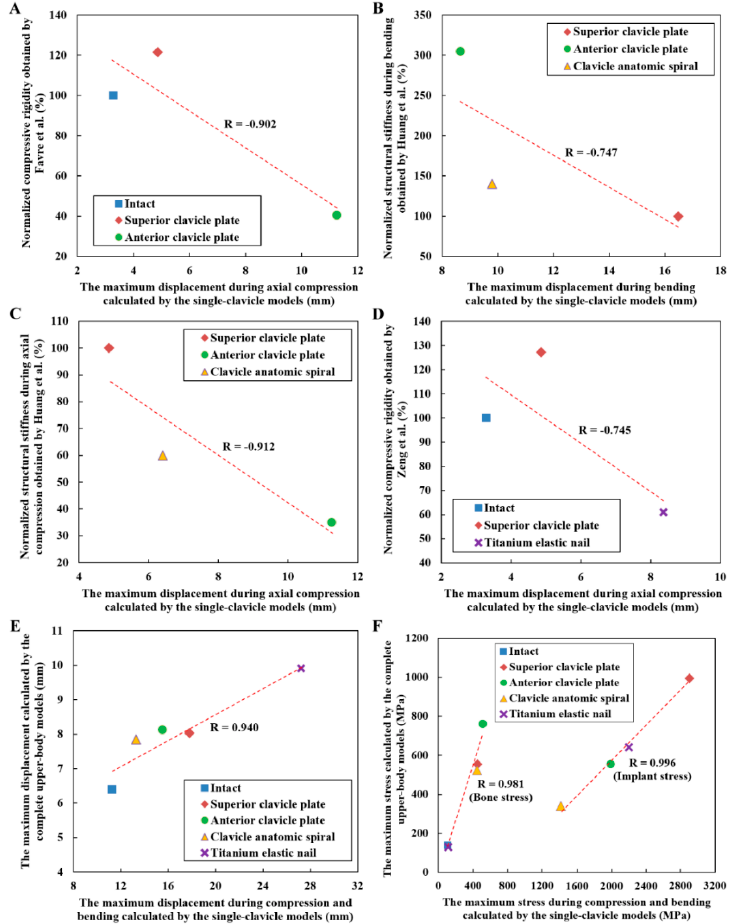
Figure 7. Results of the correlation analyses: ( A ) compared with Favre et al.; ( B , C ) compared with Huang et al.; ( D ) compared with Zeng et al.; ( E , F ) correlation between the simplified and complete models.